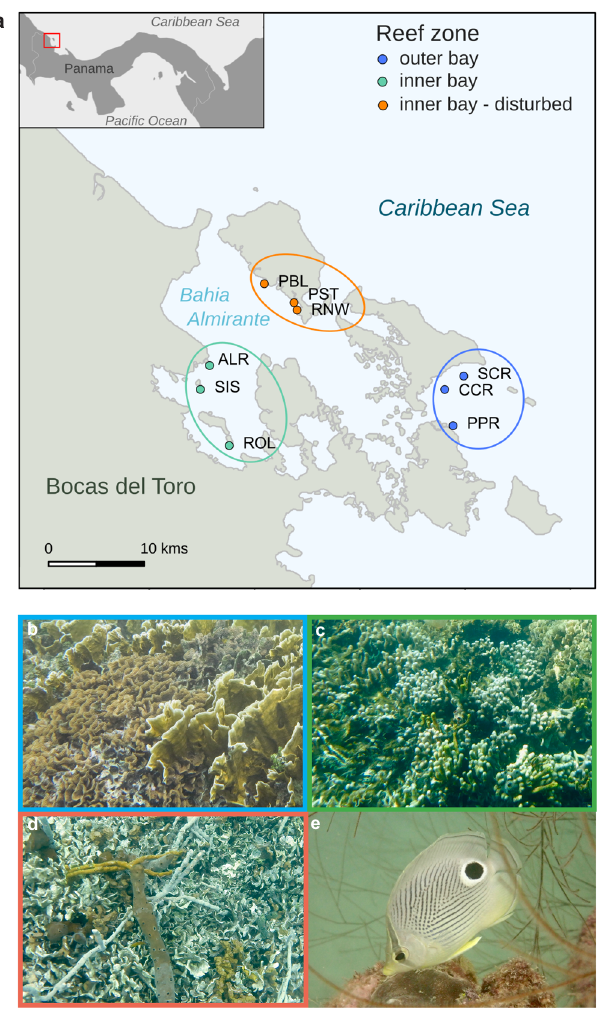
Fig. 1 Study area and fi sh species. a Map of the Bahía Almirante (Bocas del Toro, Panamá) indicating the position of the nine reefs where samples were collected (generated using GSHHG version 2.3.7 https://www.soest. hawaii.edu/pwessel/gshhg/). Data: Friederike Clever. b Outer bay reefs with highest levels of live coral cover, c inner bay reefs with intermediate levels of coral cover, and d reefs located in the inner bay disturbed zone were highly impacted by a hypoxic event in 2010. e The study species foureye butter fl y fi sh ( Chaetodon capistratus ). Photographs by Matthieu